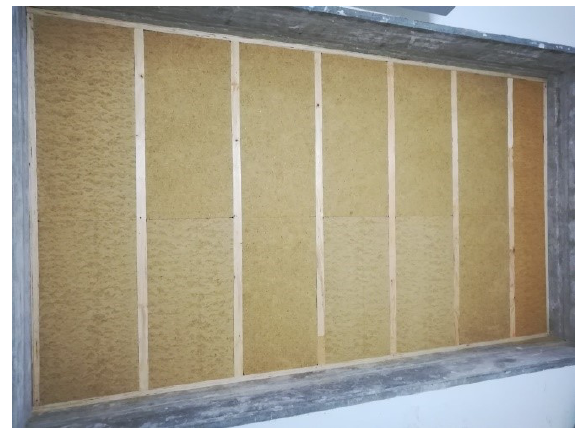
Figure 7. Wood fibre boards between I-joists STE- ICO wall.